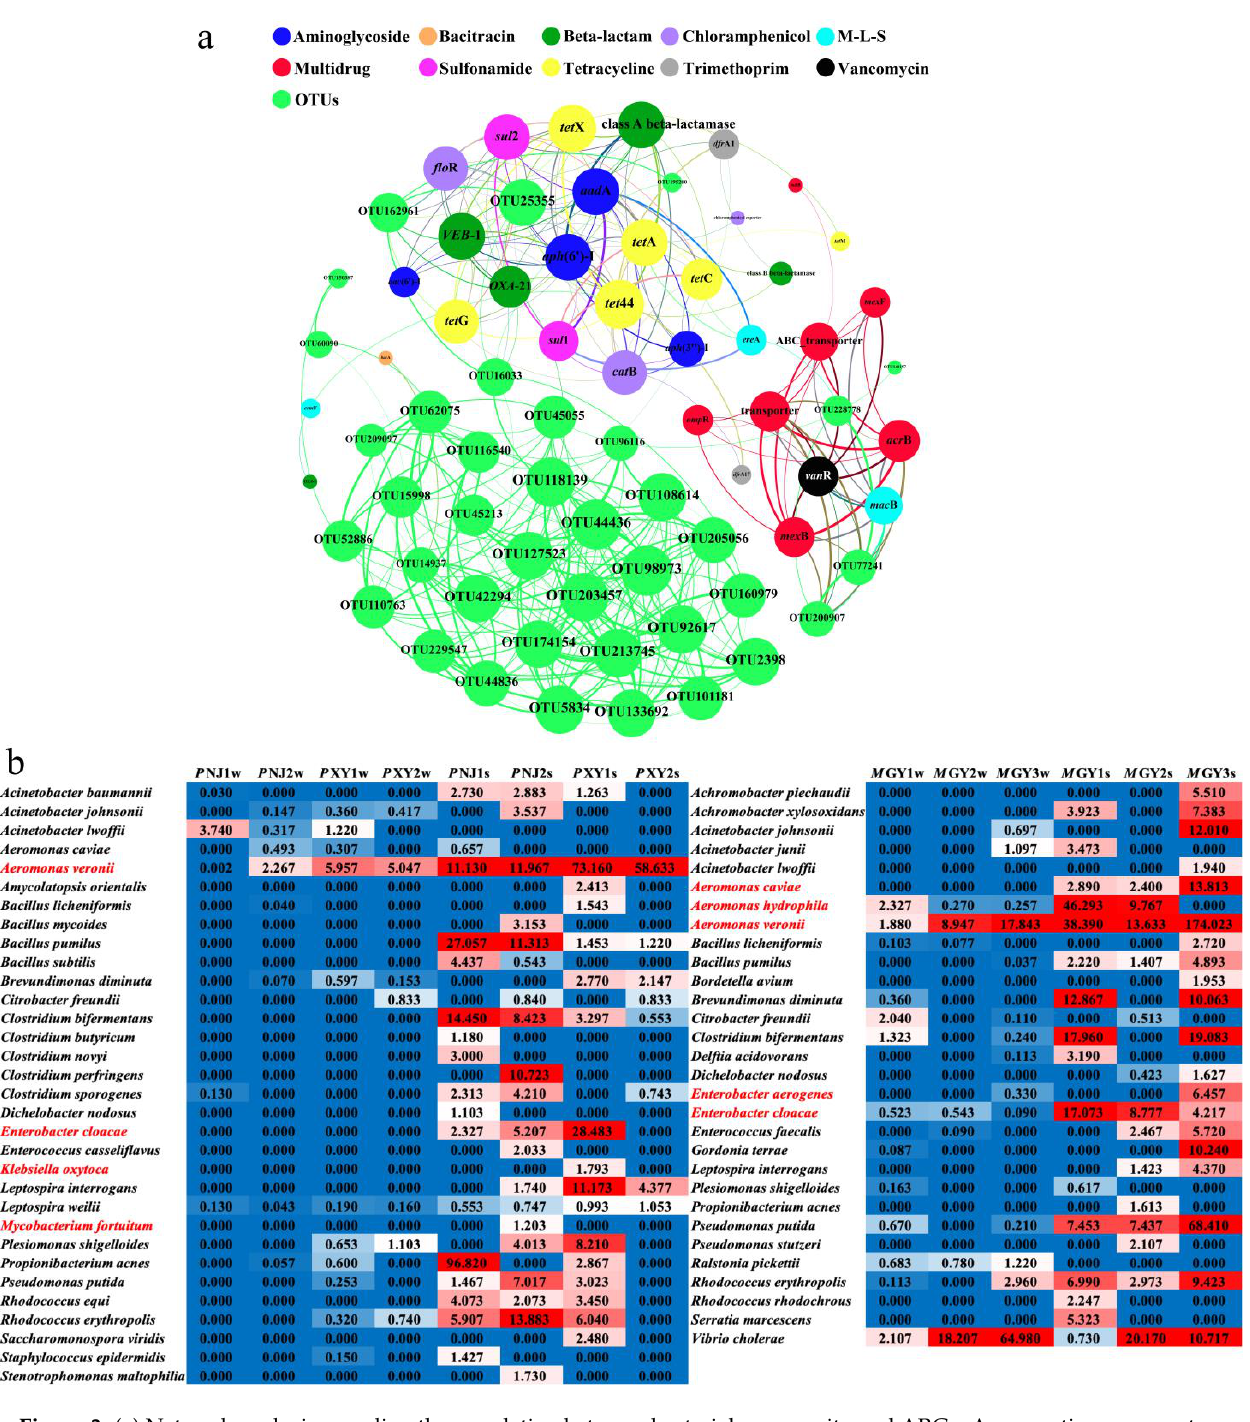
Figure 3. ( a ) Network analysis revealing the correlation between bacterial community and ARGs. A connection represents a significant positive correlation (R ≥ 0.60, P ≤ 0.01) according to the Pearson’s correlation coefficient. The size of node displayed the degree of connection. ( b ) Relative abundance (‰) of potential pathogens in water and sediment samples in aquaculture ponds.